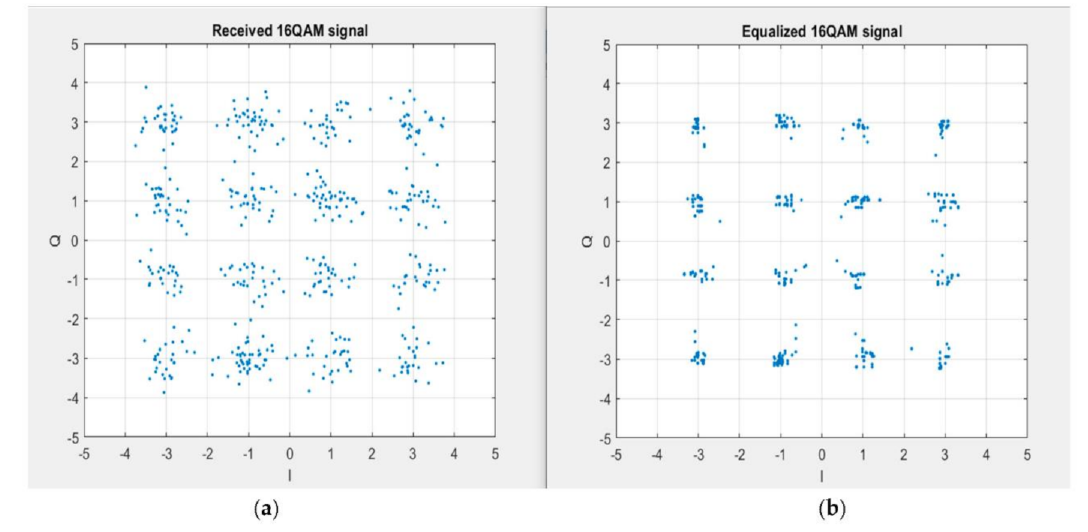
Figure 16. EVM measurements for 16QAM modulation using MF equalization (50 km SMF link). ( a ) Constellation diagram for 16QAM before equalization with EVM 15.1%. ( b ) Constellation diagram for 16QAM after LMS equalization with EVM